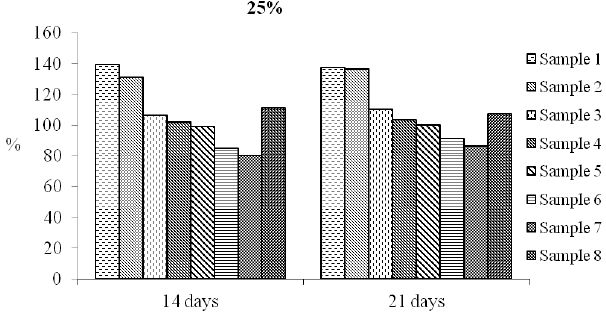
Figure 4. Comparison of the germination capacity at a concentra- tion of 25%.